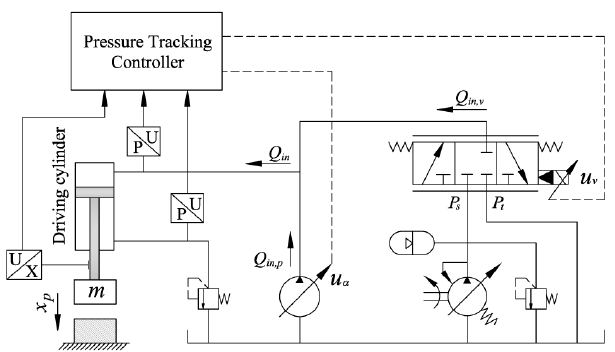
Figure 1. Schematic diagram of the hydraulic system.